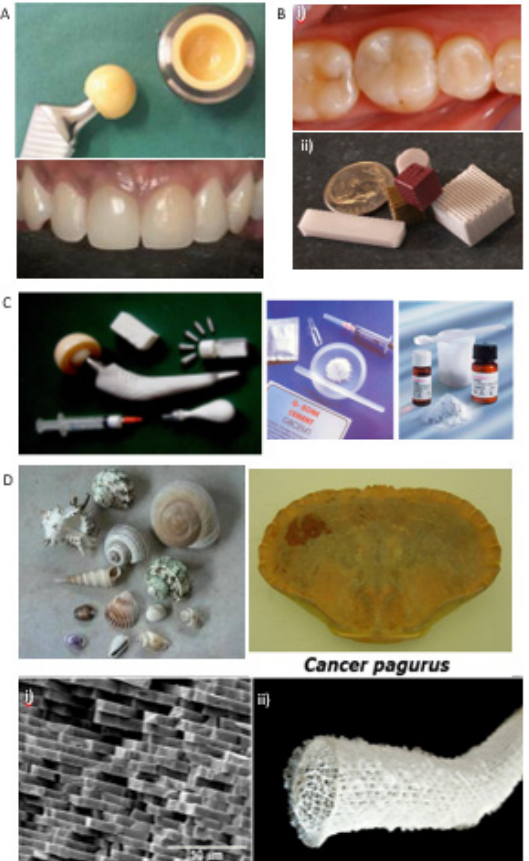
Figure 2. ( A ) Alumina/zirconia bioceramics for hip joint prosthesis and dentistry [67,68]; ( B ) (i)